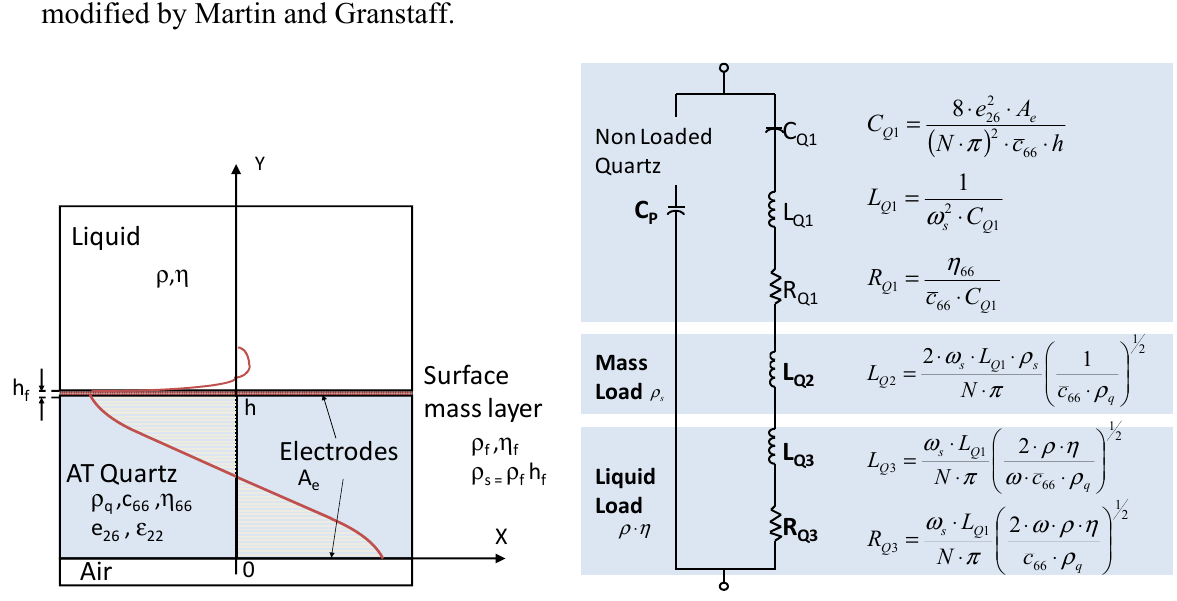
Figure 1. Electromechanical model of a piezoelectric resonator for microgravimetrical applications in liquid; Cross-section of a loaded resonator and BVD equivalent circuit modified by Martin and